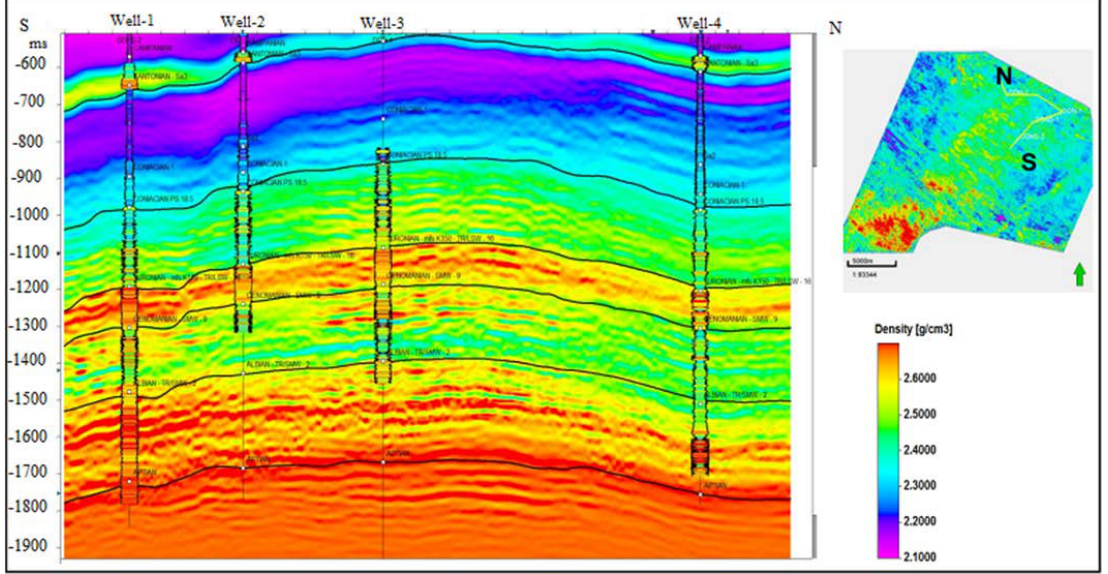
Figure 1. Seismic trace crossing the four wells from the inverted density cube of the southeastern Algerian petroleum field. The lithologies from top to bottom are: Maastrichtian, Campanian, Santo- nian, Coniacian, Turonian, Cenomanian, Albian, and Aptian.